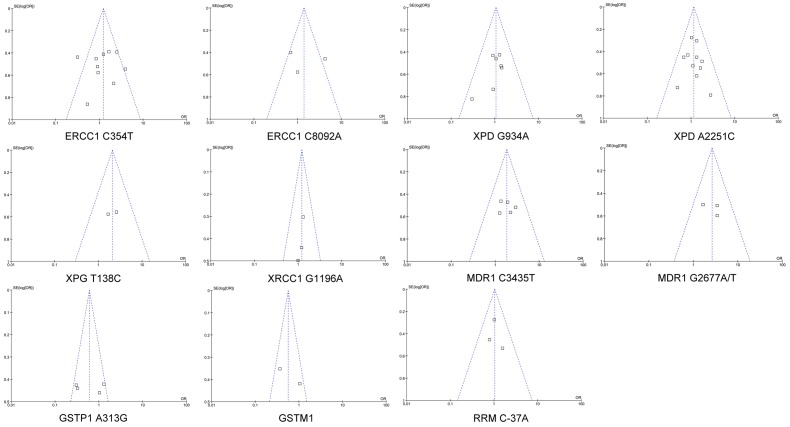
Funnel plots of SE (log [OR]) by the OR in meta-analysis. SE (log [OR]) is standard error of log [OR]. Each dot represents one article.